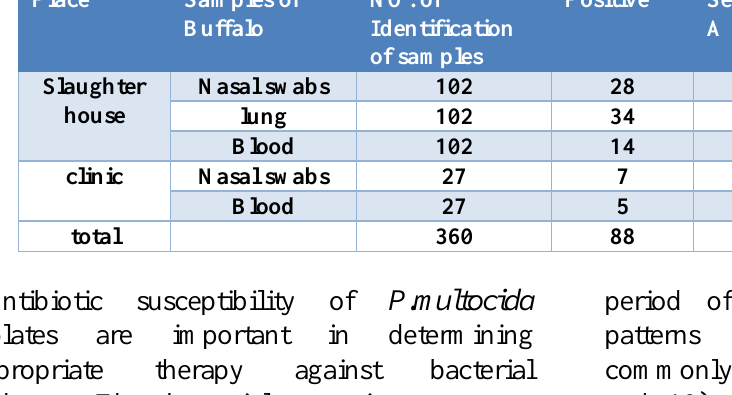
Table, 5: Shows types of samples taken from buffaloes and the positive cases HS. Place Samples of